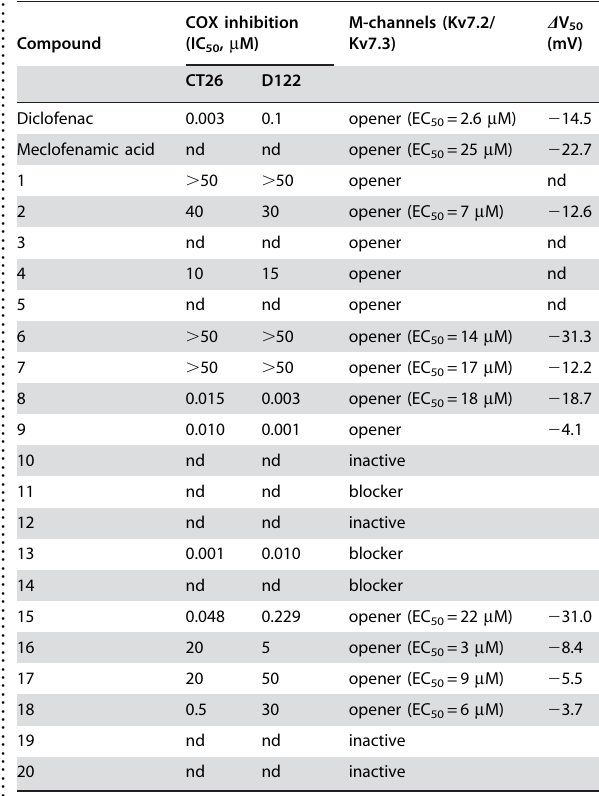
Table 1. SAR studies of derivatives of diclofenac and